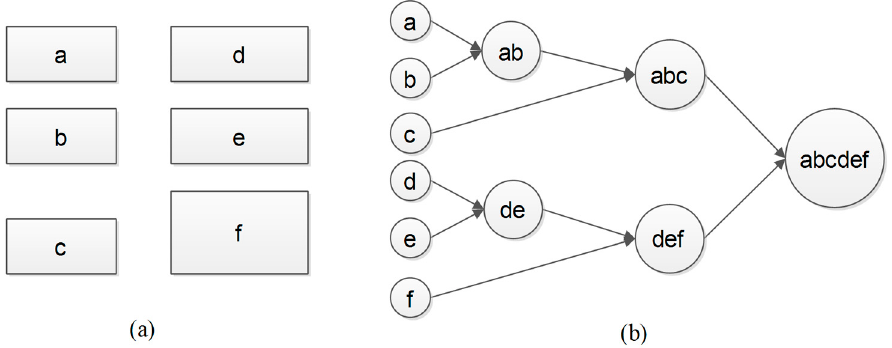
Figure 15. Model organization: ( a ) model’s footprints; ( b ) clustering order.